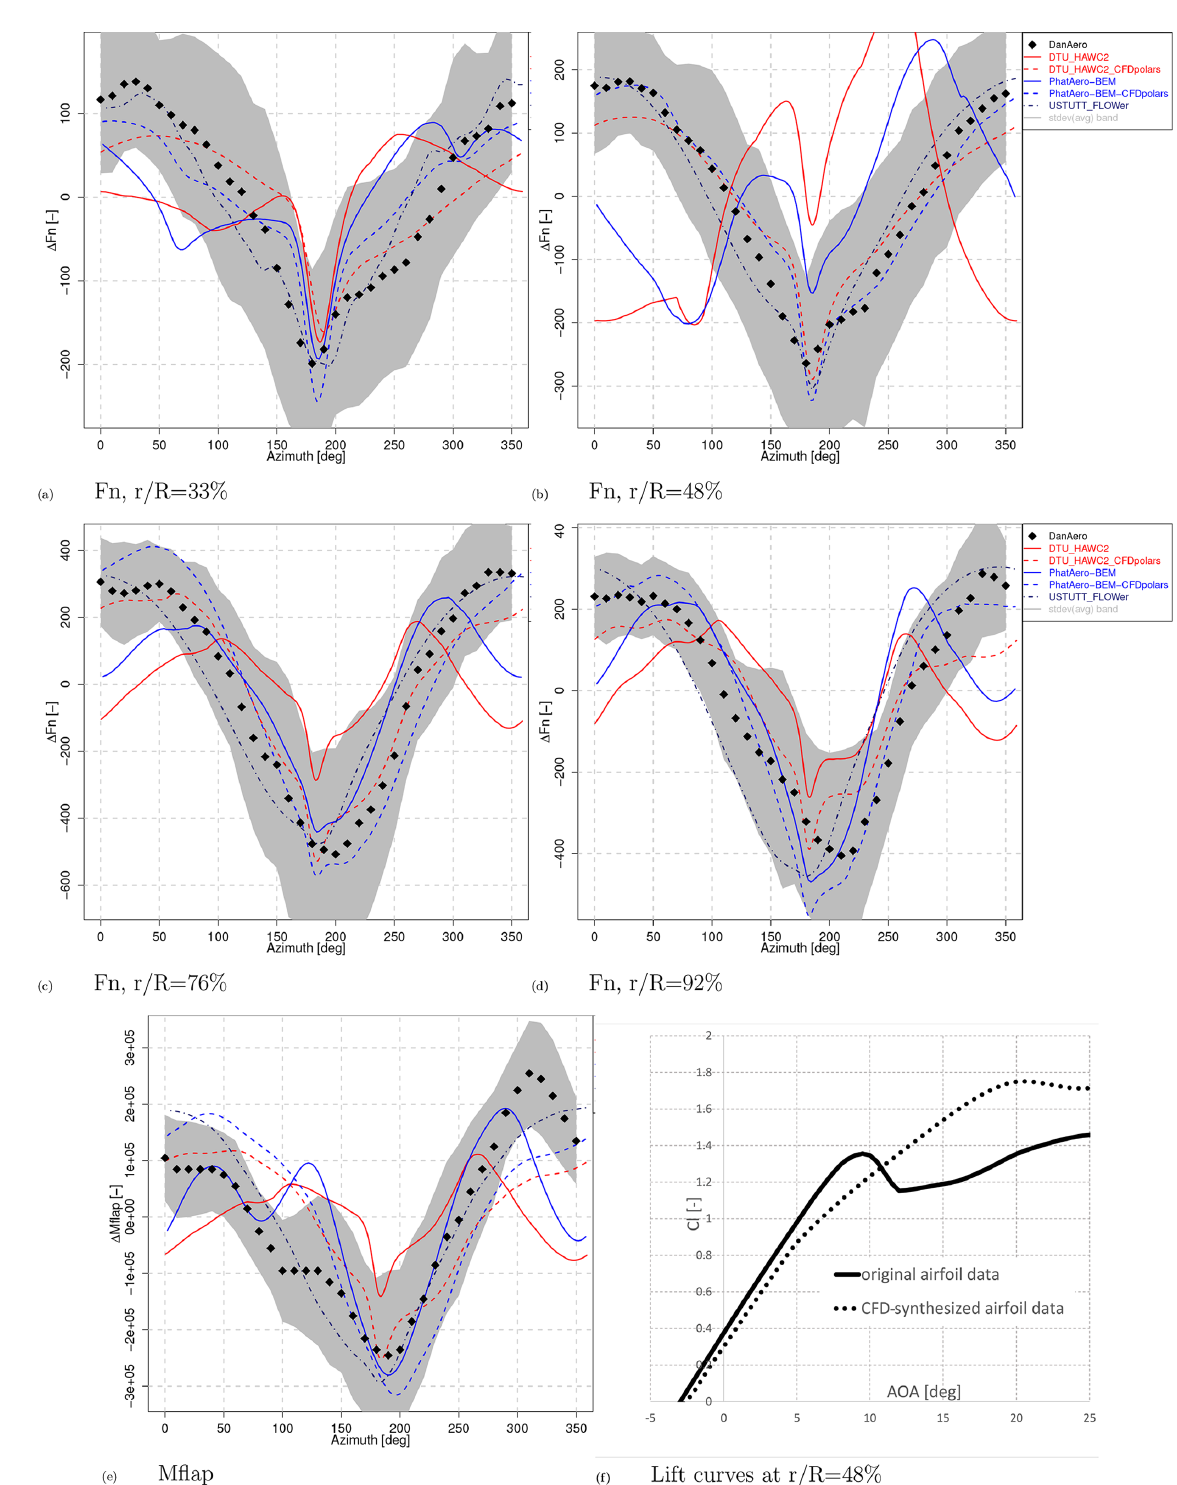
Figure 11. Normal force (Fn) variation and airfoil data using CFD-synthesized airfoil data, Case IV.2.1. USTUTT reference CFD data are plotted as